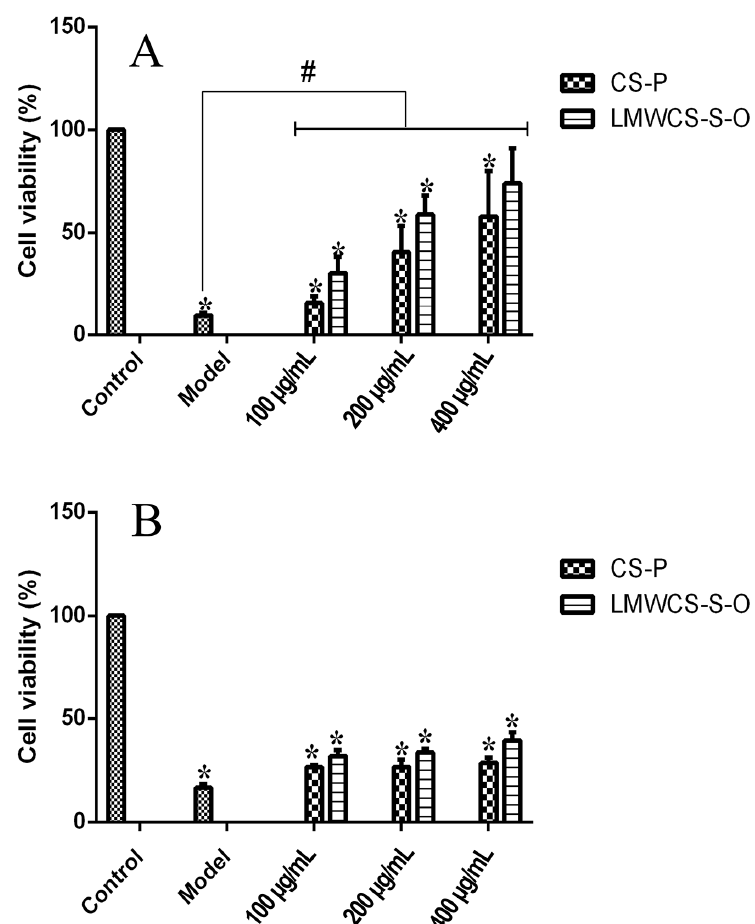
Figure 5. Articular chondrocytes cell death mediated by normal human serum (NHS) at 12 h ( A ); and 24 h ( B ), respectively. The LMWCS-S-O group at 400 µ g/mL did not show a significant difference from the control group at 12 h. The cell viabilities of all the other groups were significantly lower compared to the control group. All groups showed a protective effect compared to the model group (* p < 0.05 vs. the control group, # p < 0.05 vs. the model